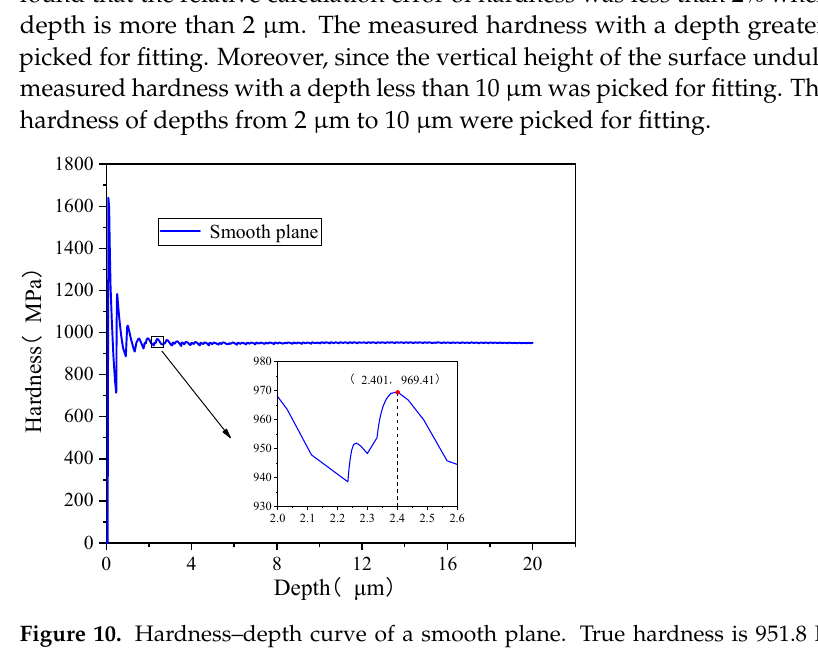
Figure 10. Hardness–depth curve of a smooth plane. True hardness is 951.8 MPa. The relative calculation error of hardness is less than 1.8% when indentation depth is more than 2 μm.